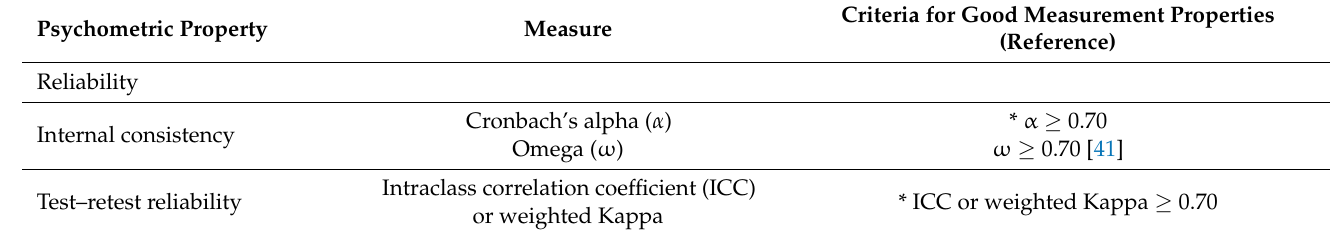
Table 1. Criteria for evaluating the qualities of psychometric properties of current ToM